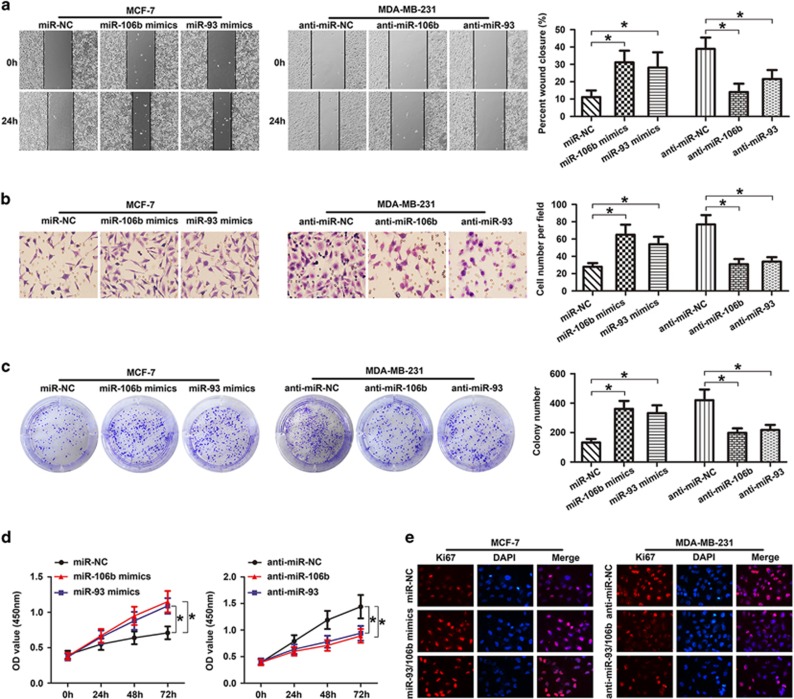
MiR-106b, miR-93 regulated the capacity of cell migration, invasion and proliferation in vitro. The ability of cell migration and invasion in MCF-7 cells with miR-NC, miR-106b mimics or miR-93 mimics and in MDA-MB-231 cells transfected with anti-miR-NC, anti-miR-106b or anti-miR-93 based on wound-healing (a) and transwell assays (b). The proliferative character in MCF-7 cells transfected with miR-NC, miR-106b mimics or miR-93 mimics and in MDA-MB-231 cells with anti-miR-NC, anti-miR-106b or anti-miR-93 according to colony formation (c), CCK8 (d) and IF assays (e). Each experiment was independently repeated at least three times. Data were presented as mean±S.D. (*P<0.05)